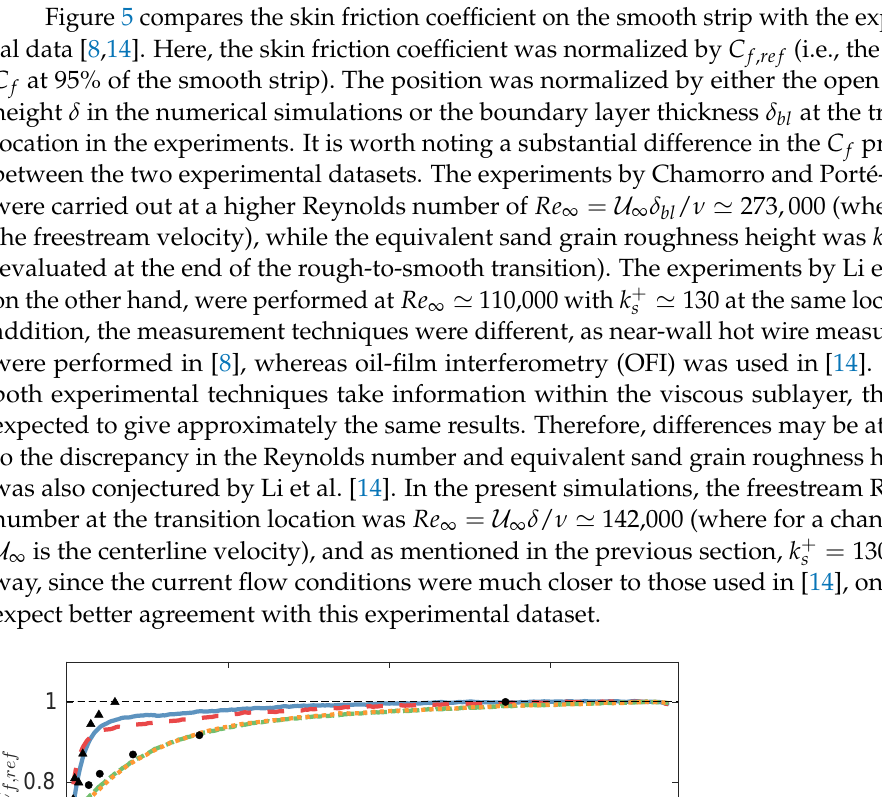
Figure 4. IDDES- k s model: mean velocity profile at the locations shown in the insets, compared with the mean velocity profile at the rough reference location. The different positions are located: ( a ) before the dip, ( b ) at the dip, ( c ) at the crest, ( d ) after the crest.